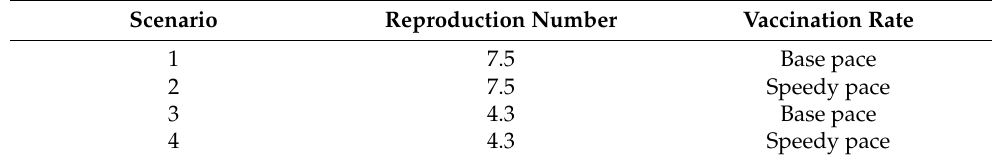
Table 3. Scenarios of